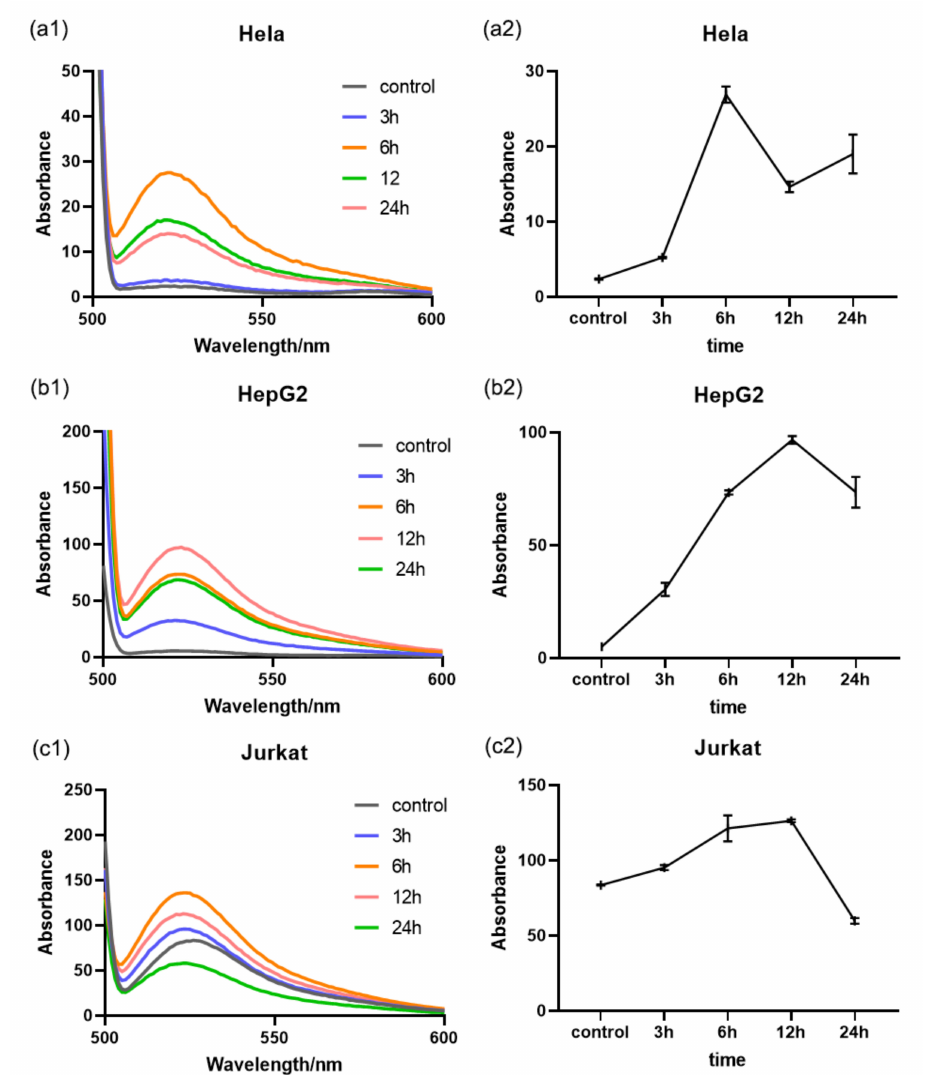
Figure 6. ( a1 – c1 ) intracellular ROS levels of the three Rg3-treated cell types, as determined using the absorbance measurements taken with the DCFH-DA probe; ( a2 – c2 ) intracellular ROS level changes versus treatment time.